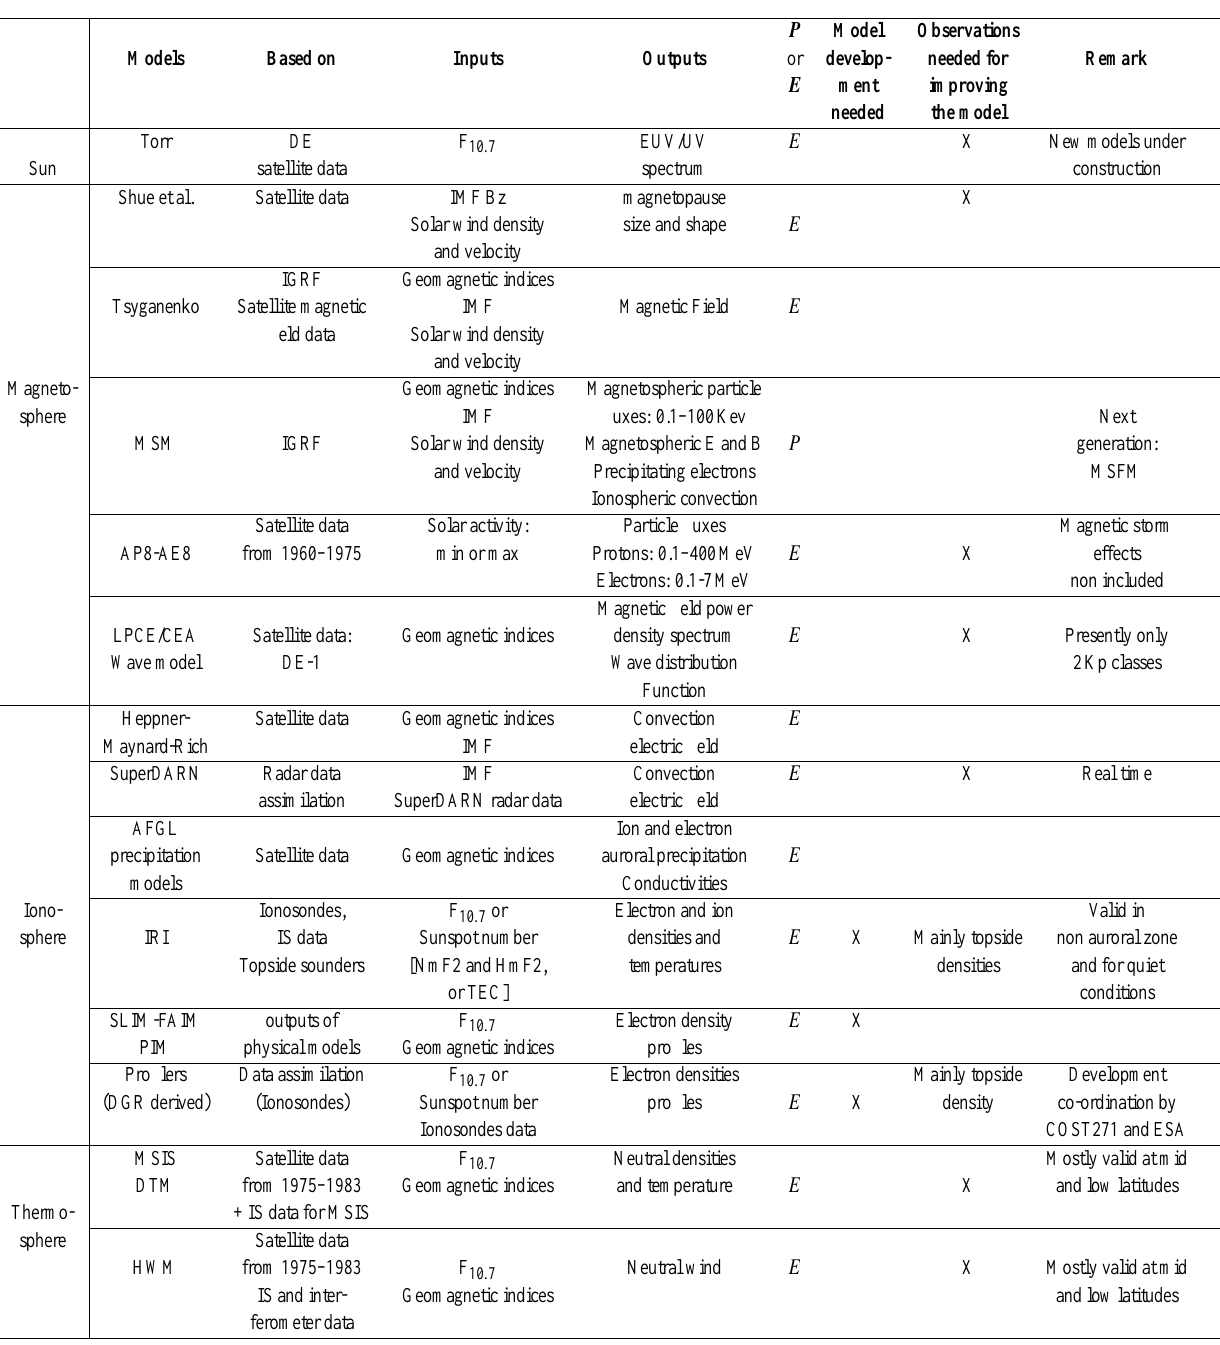
Table 2. Synthesis of model inputs and outputs of pre-operational and operational models. Only the ones most often used in a given category are indicated. A column indicates if the model is a physical one ( P ) or a semi-empirical or empirical one ( E ) and 2 columns state whether development of the model itself or availability of new observations is the most crucial for its